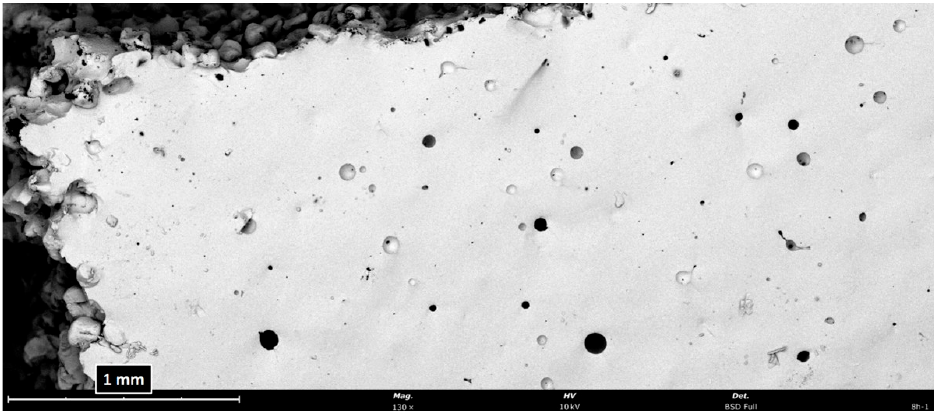
Figure 13. SEM image of the corner of the fracture surface of a specimen from the 1h batch. Image obtained in the desktop SEM Phenom Pro G6 from Thermo Fisher Scientific (Waltham, MA, USA), after samples were coated with gold and palladium.